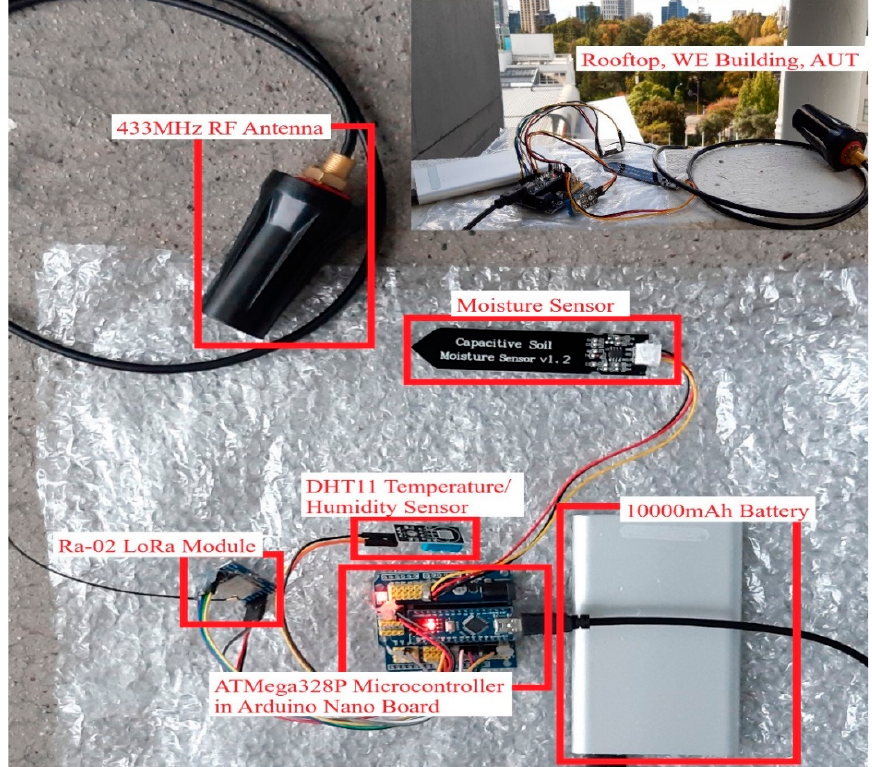
Figure 4. Deployment of LoRa transmitter node–02 at the rooftop of the AUT building.